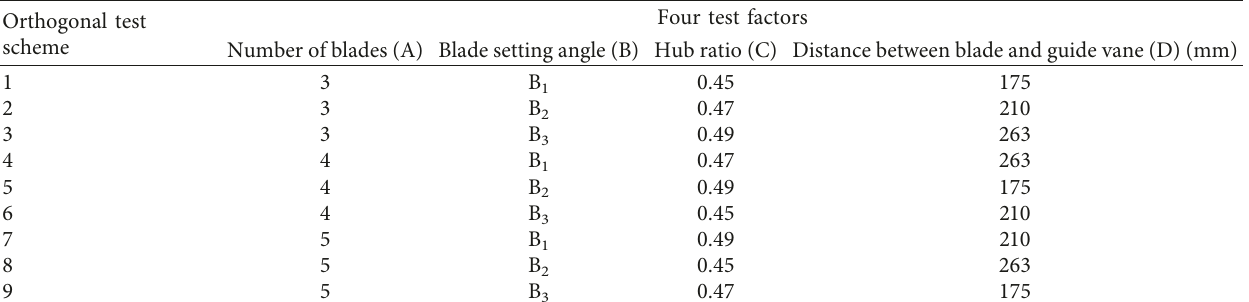
Table 2: Orthogonal table of the axial flow pump.